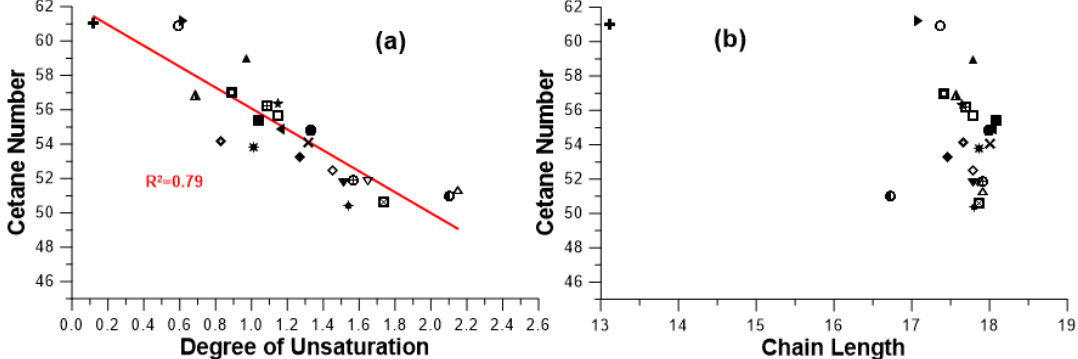
Figure 2. Correlation between degree of unsaturation (a) and chain length (b) with biodiesel average cetane number from 24 feedstocks (sub-figure (a) reprinted from [6] with permission from Elsevier).